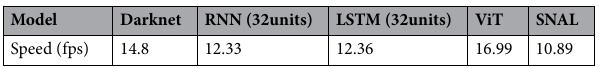
Table 3. Comparison of test speed of each